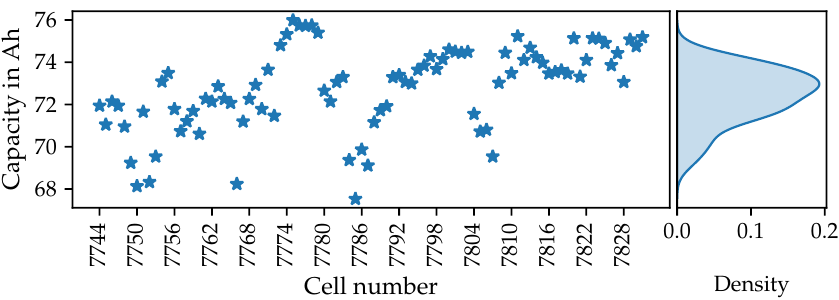
Figure 7. All cells and their capacities derived from one charging record.